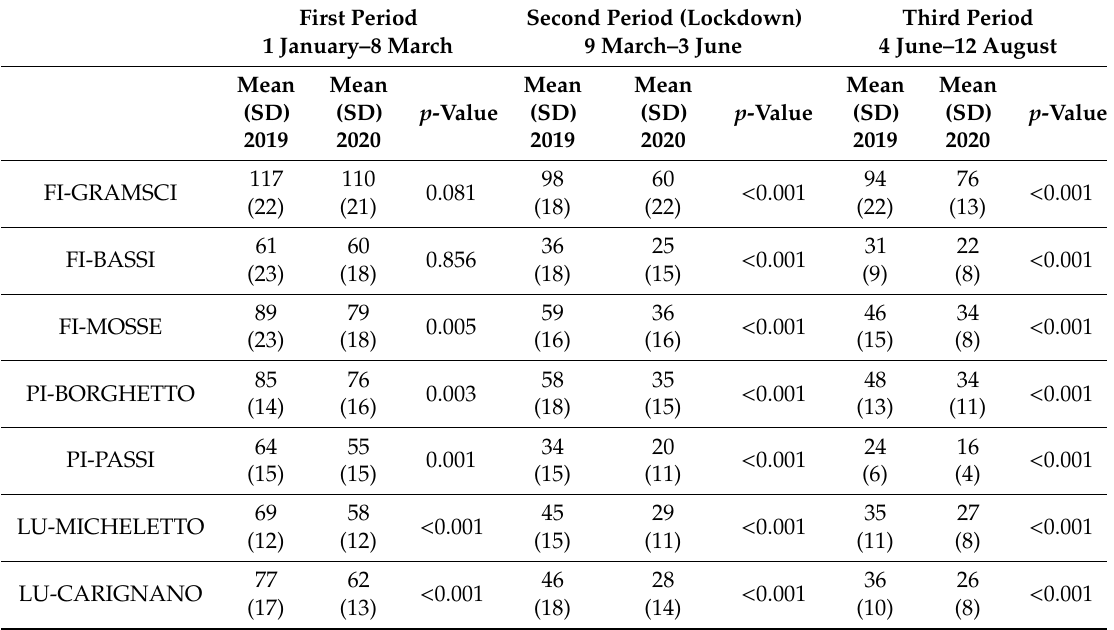
Table 4. Output of the two-sample t -test to evaluate the e ff ects of lockdown on NO 2 air concentrations. The NO 2 values are expressed in µ g · m − 3